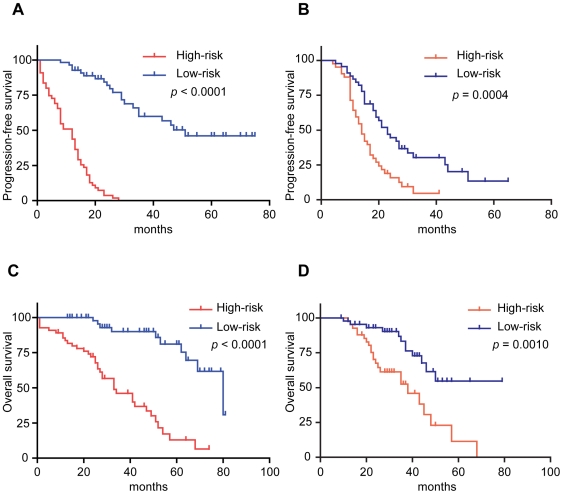
Prediction of prognosis in high-risk and low-risk patients based on the prognostic index.High-risk patients had significantly short progression-free survival times compared to low-risk patients (A) in the discovery set (log rank test, p<0.0001) and (B) in the external set (log rank test, p = 0.0004). Similarly, high-risk patients had significantly shorter overall survival times compared to low-risk patients (C) in the discovery set (log rank test, p<0.0001) and (D) in the external set (log rank test, p = 0.0010).